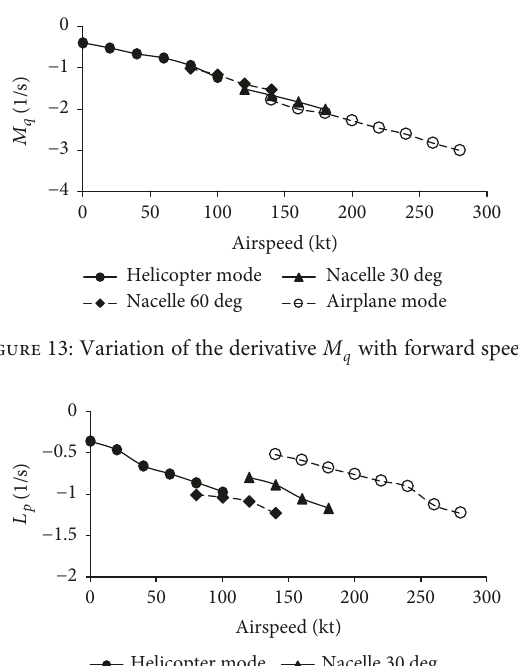
with forward speed. w